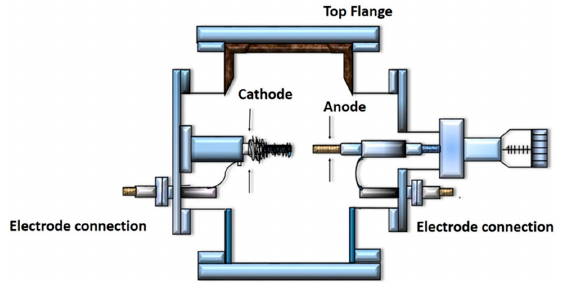
Table 1. Comparison between SWCNTs and MWCNTs [23].